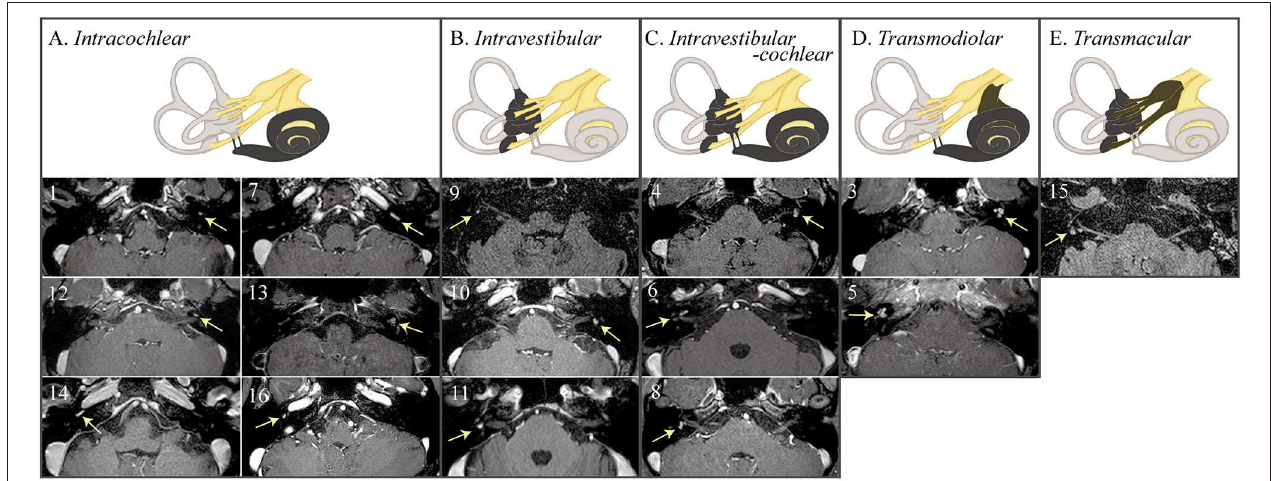
FIGURE 3 | MRIs of the patients with intralabyrinthine schwannoma (ILS) according to Kennedy classification. 3D contrast-enhanced T1 or fluid attenuated inversion recovery (FLAIR) images show nodular enhancements within the labyrinth (arrows).